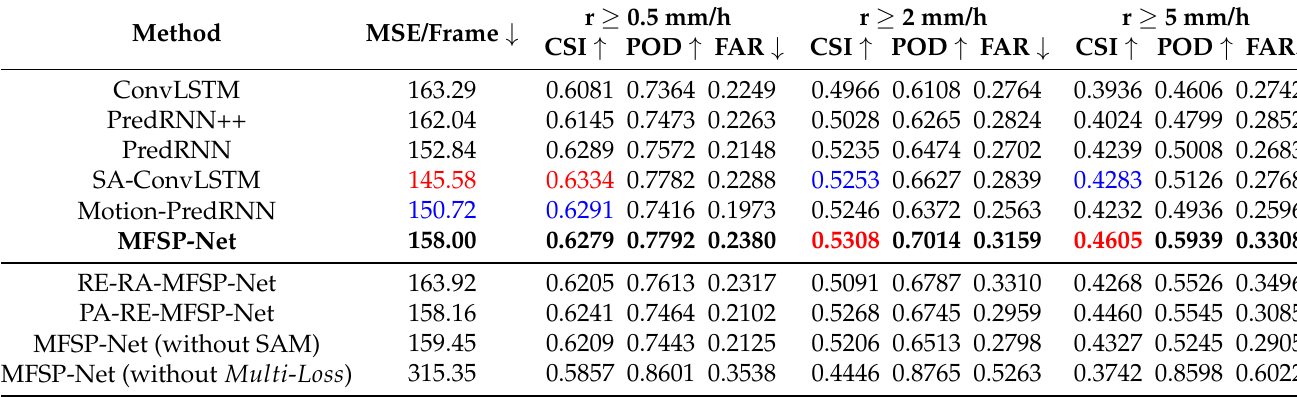
Table 7. Average evaluation results of five frames of precipitation intensity nowcasting in the first hour. For MSE and CSI, the best performance is reported using red, and the second best is reported using blue. “ ↑ ” means that the higher the score, the better, while “ ↓ ” means that the lower the score, the better. “ r ≥ γ ” means the skill score at the γ mm/h rainfall threshold.